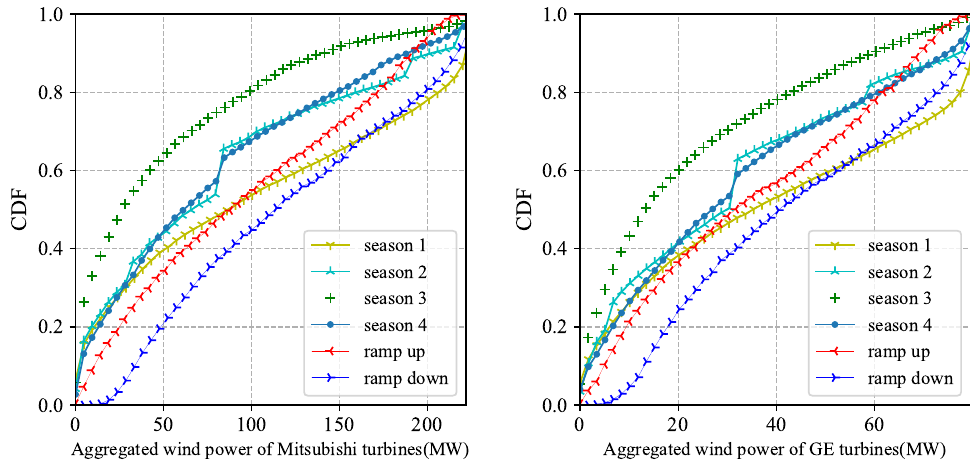
Figure 3. Empirical distribution of power outputs of GE and Mitsubishi turbines in 4 seasons and ramp events, where season 4 is from October to